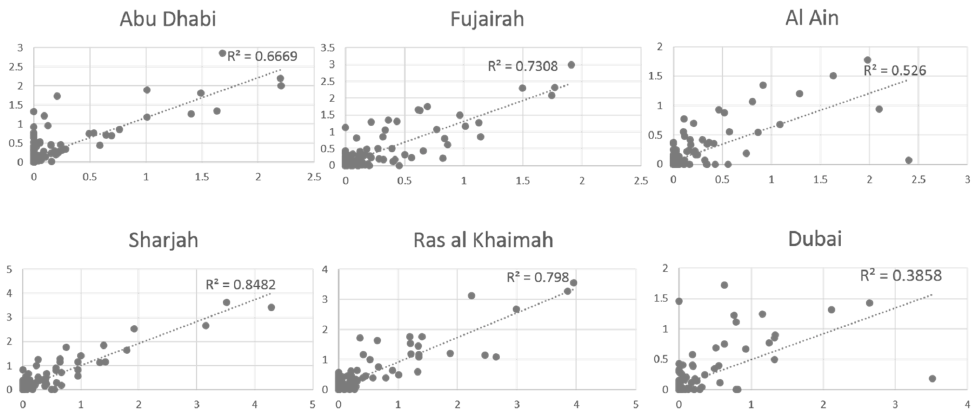
Figure 15. Precipitation correlation analysis between ground stations data (horizontal axis) and TRMM measurements (vertical axis) in six ground stations in the UAE.